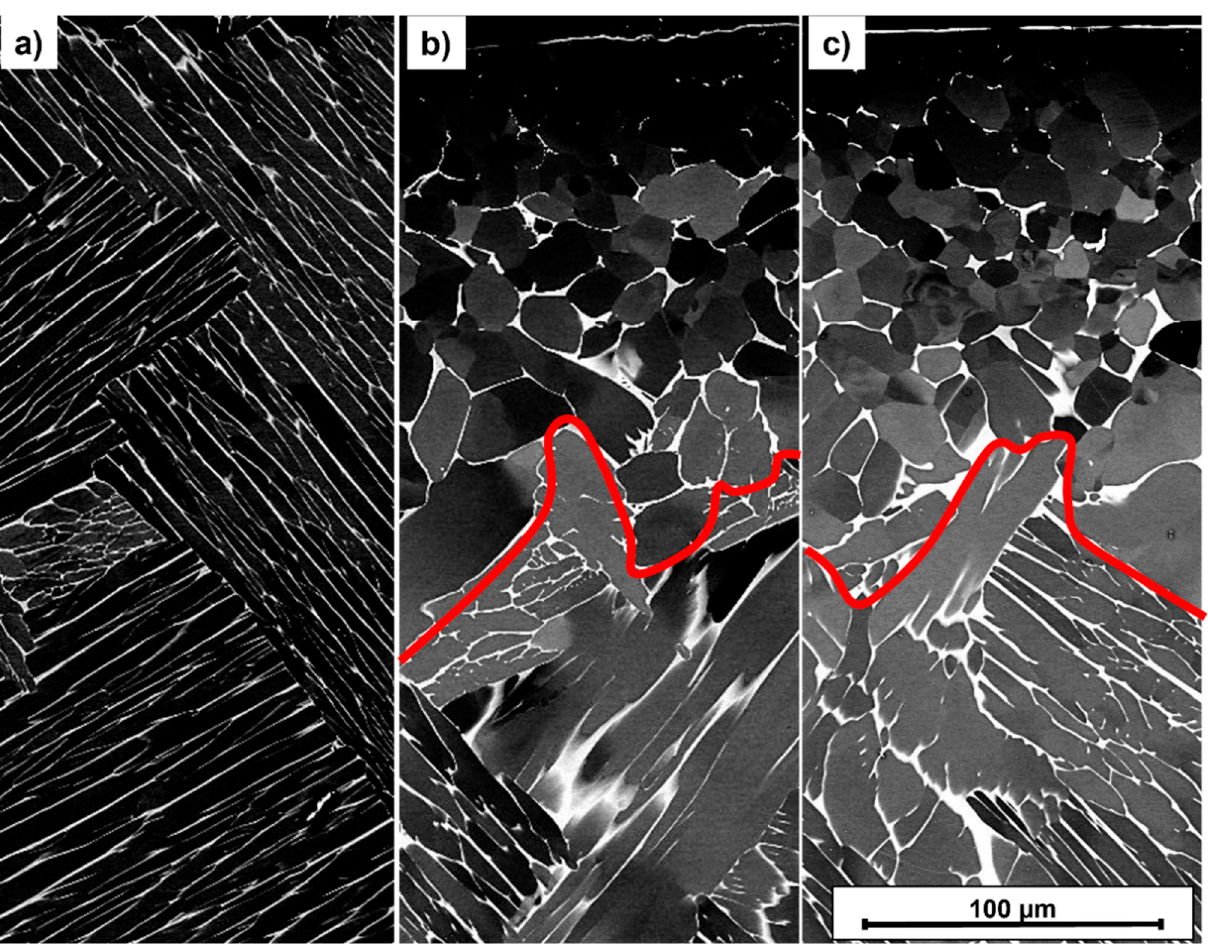
Figure 5. SEM-BSE Micrographs of the near-surface area (sample’s surface is located on top) after solution treatment A ( a ) and THT acc. to path A ( b ) and path B ( c ); the red line indicates the boundary between equiaxed and lamellar grain morphology.